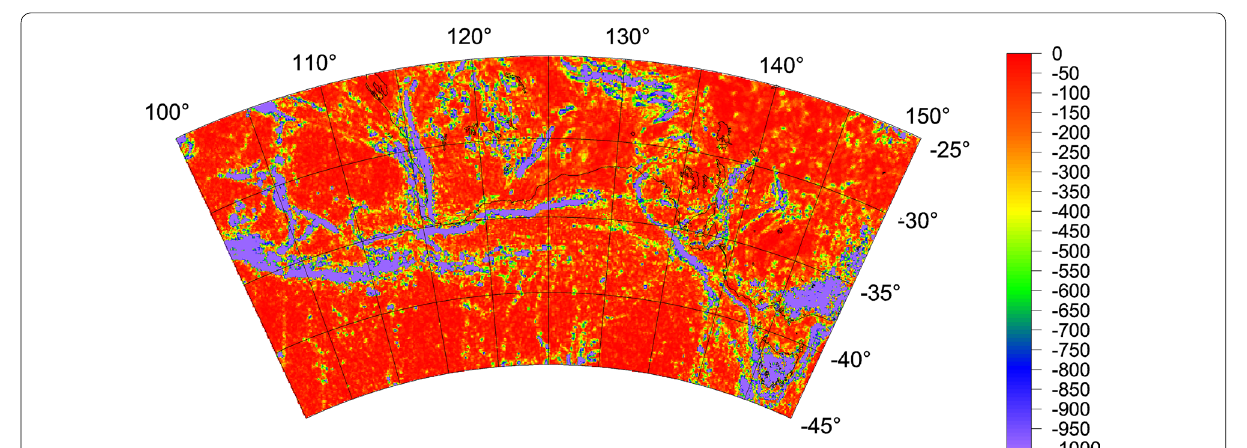
Fig. 16 I 1 [s − 4 ] for southern Australia with EIGEN